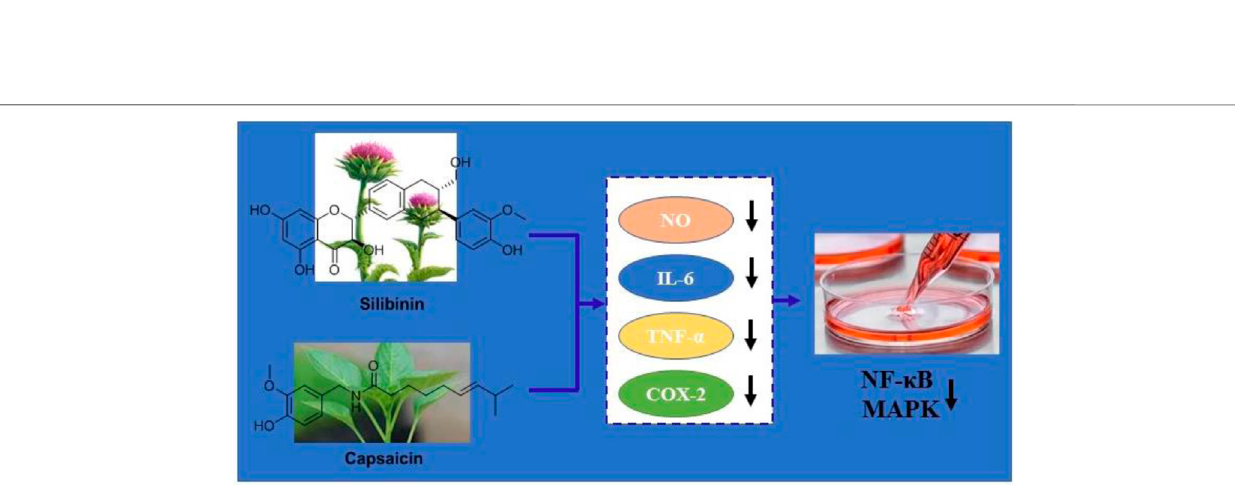
Frontiers in Chemistry |